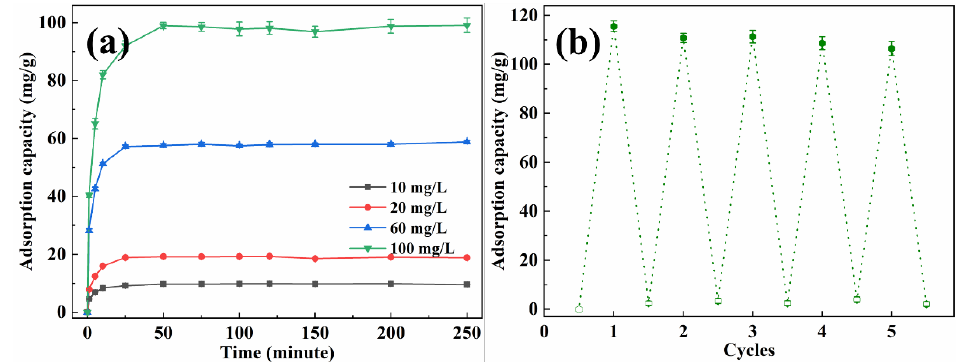
Figure 9. ( a ) The adsorption capacity of EP-3 for Cr(VI) with various concentrations; ( b ) recyclability test of EP-3.